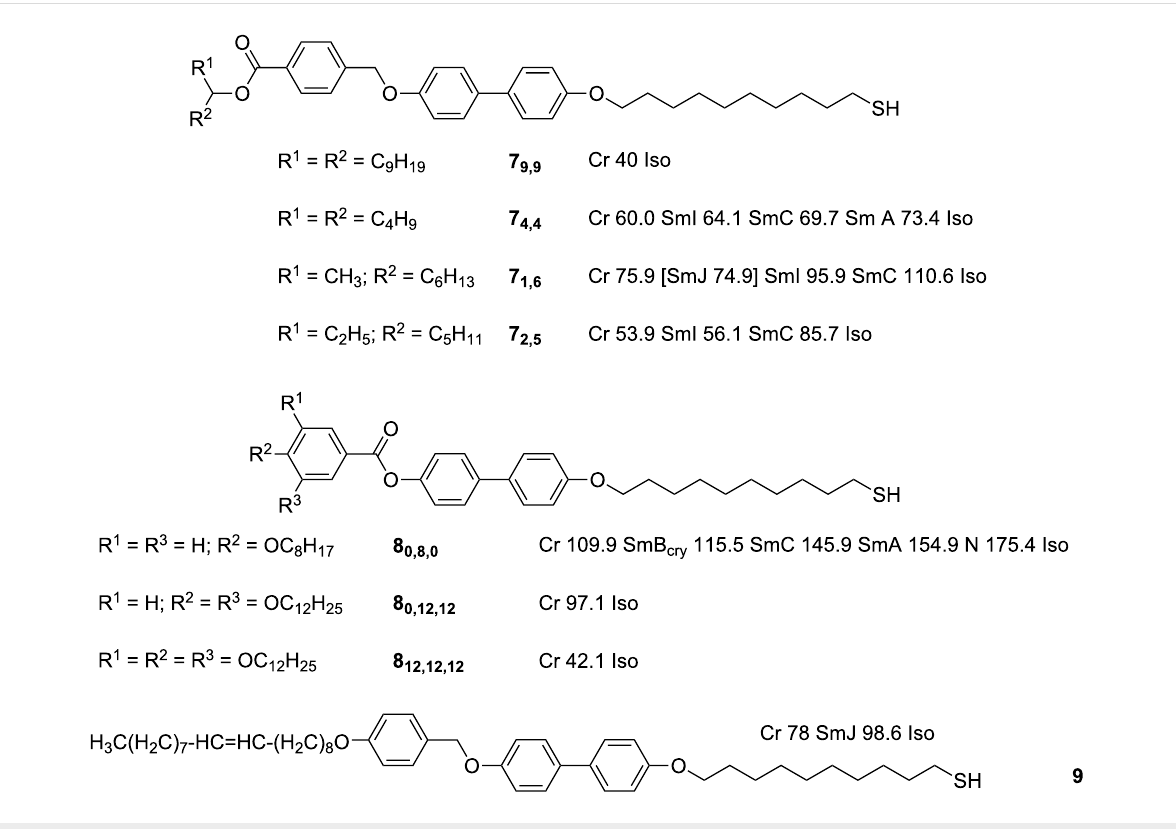
The role of subtle changes to the mesogenic ligand in deter- mining the LC phase of the hybrids was highlighted by the results observed for the mesogenic thiols 7 4,4 , and 7 1,6 , which differ from 7 9,9 only in the length of the alkyl chains on the periphery of the molecule. In the case of Au@C 10 /7 4,4 and Au@C 10 /7 1,6 , the smectic arrangement observed for Au@C 10 / 7 9,9 was replaced by columnar structures (Table 1), with the columns organised into body-centred orthorhombic unit cells, and an arrangement very close to being hexagonal. This arrangement is possible by shifting of the particles by c /2 along the column axis, which can be readily changed into the smectic phase through another shift of c /2, followed by positional decoupling of the layers along the c axis (Figure